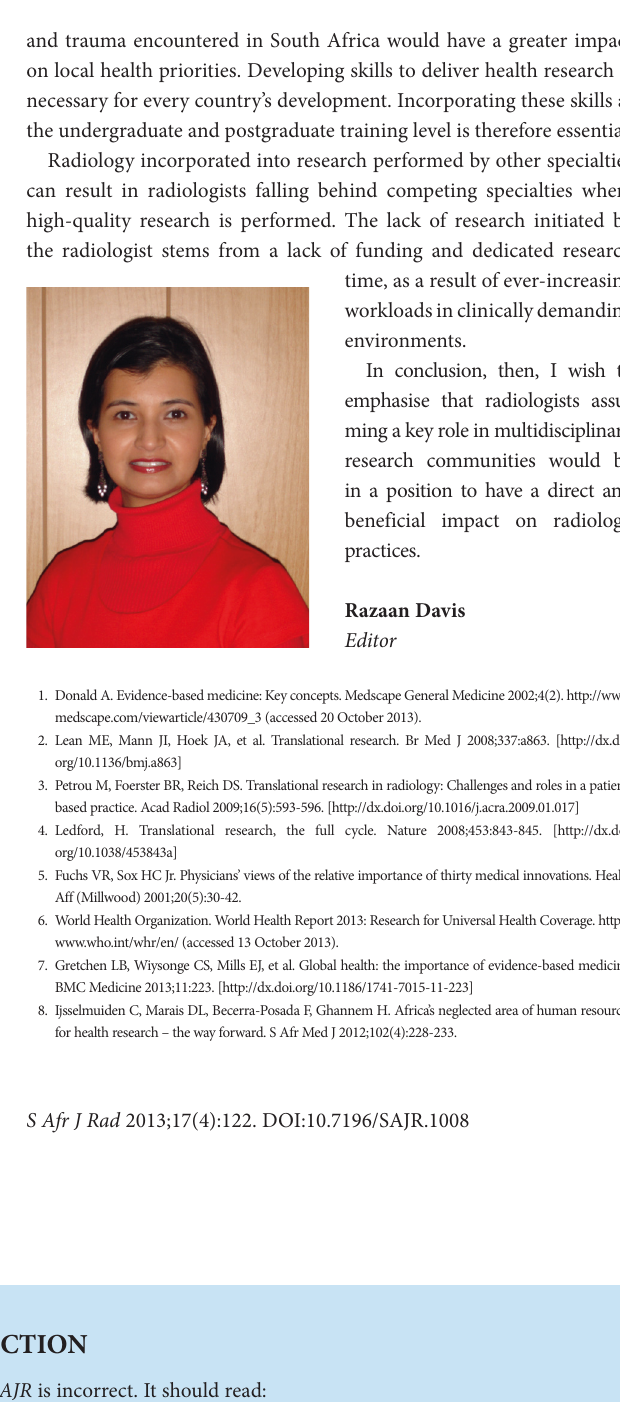
Fig. 3b. Fetal MRI, coronal T2, in the same fetus, demonstrating enlarged echogenic kidneys. This finding in conjuction with the molar tooth sign is consistent with a diagnosis of the JSRD renal